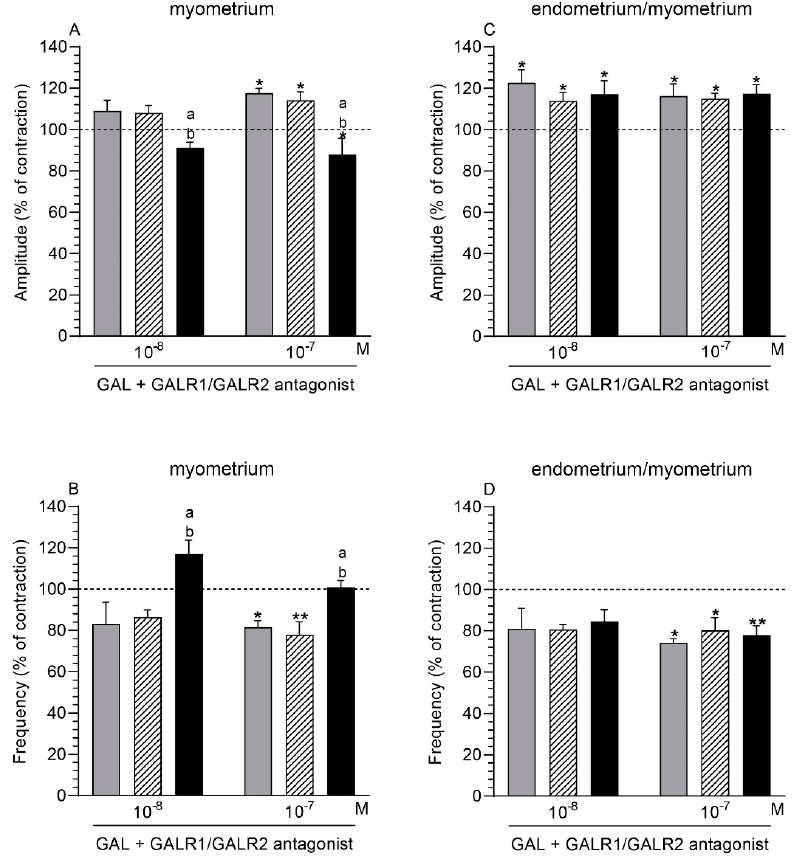
Figure 5. The influence of galanin (GAL) on the contractile amplitude ( A , C ) and frequency ( B , D ) in the myometrium ( A , B ) and endometrium/myometrium ( C , D ) stripes of gilts from the CON (grey bars), SAL (hatched bars), and E. coli (black bars) groups after using GALR1/GALR2 antagonist (at a dose of 10 − 6 M). Results were calculated for five gilts in each group. The effects of antagonist and individual GAL doses are depicted as percentages (mean ± SEM) of the baseline (pretreatment period) contractile amplitude and frequency, taken as 100% (horizontal lines). * P < 0.05, ** P < 0.01 compared to the basal value in each group; a P < 0.05 compared between the CON and E. coli groups for the same treatment; b P < 0.05 compared between the SAL and E. coli groups for the same treatment.